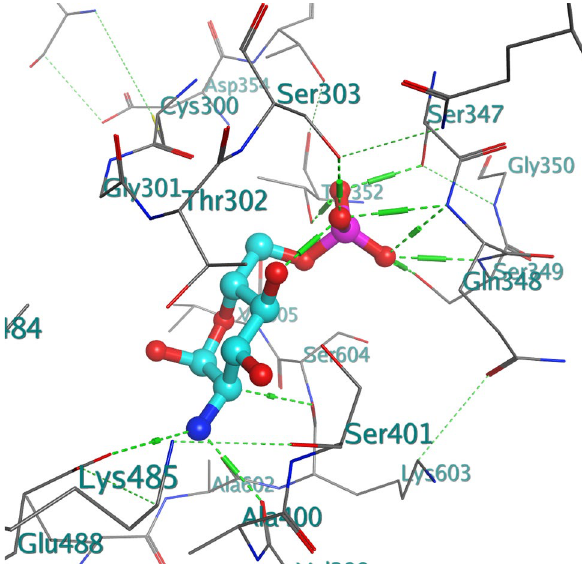
Figure 3. Binding pose of compound 6g in the binding cavity of 2VF5.